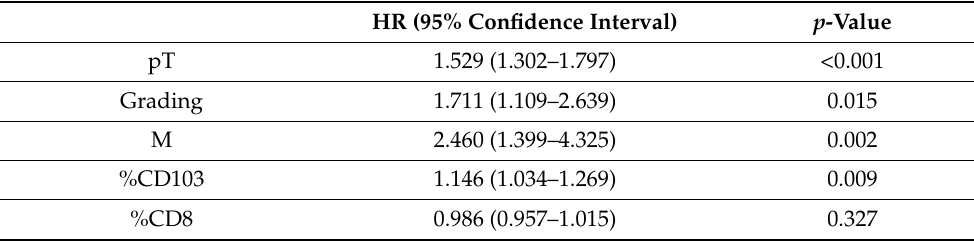
Table 8. Multivariate Cox regression analyses (Berlin cohort, n = 197 patients, p < 0.001).